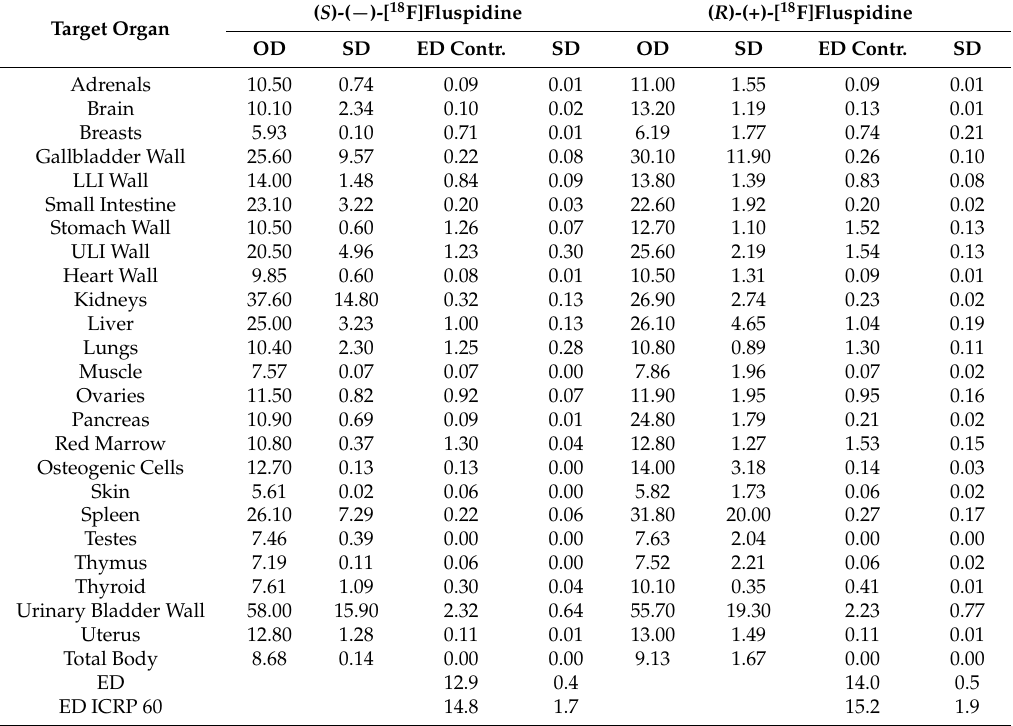
Table 1. OD and ED in µ Sv/MBq based on the imaging method with a small animal PET/MRI. ODs calculated for the adult male model (73.7 kg, implemented in OLINDA) based on mouse biodistribution and organ geometry data that were scaled proportionately to human